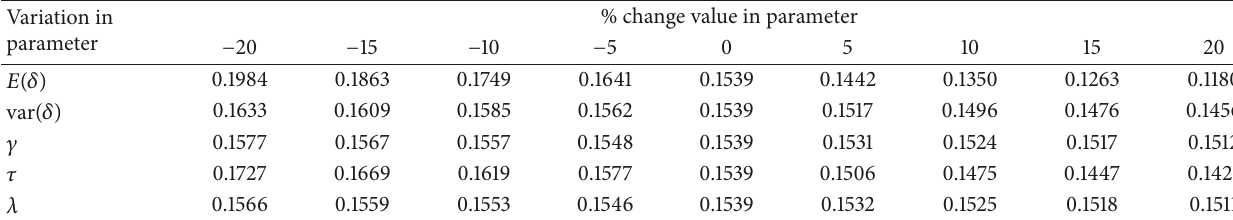
Table 4: Effects of changing four categories of parameters on 𝑄 𝑇 .